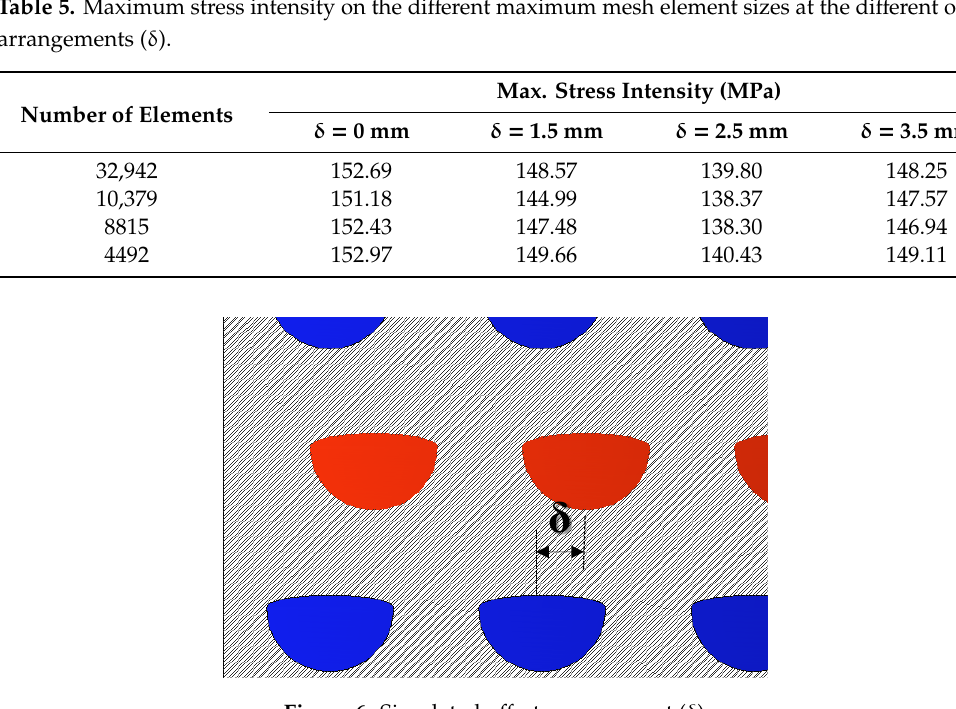
Table 5. Maximum stress intensity on the different maximum mesh element sizes at the different offset arrangements ( δ ).